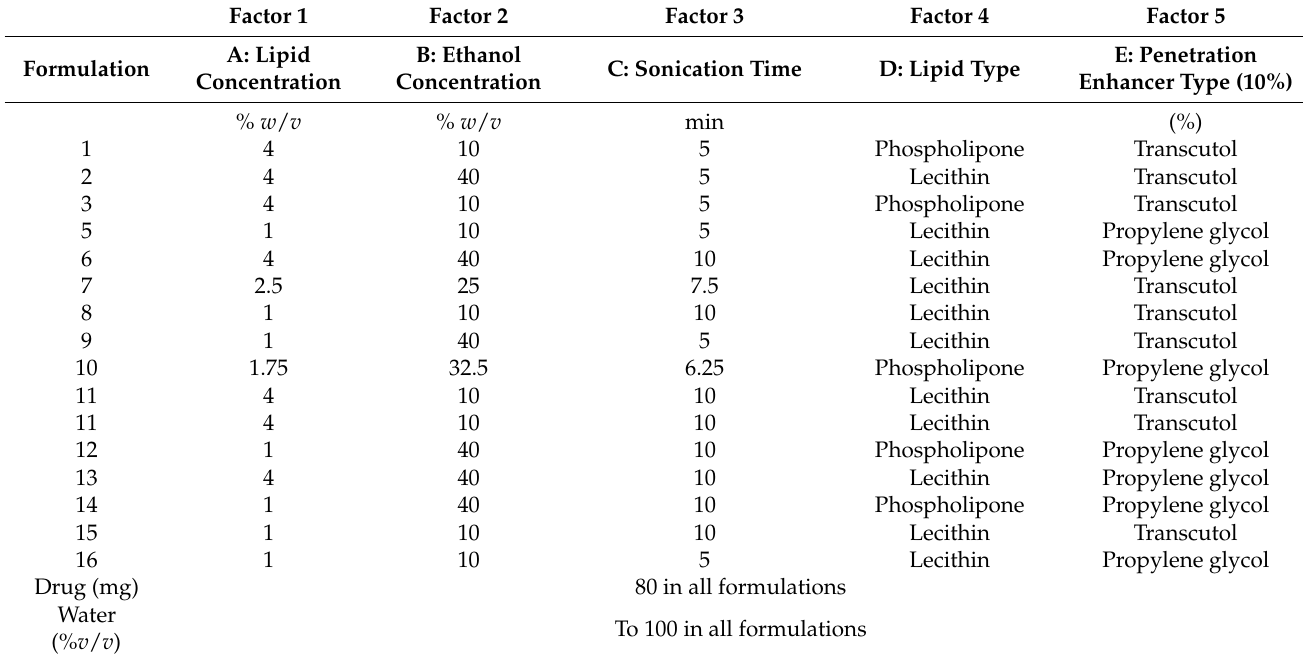
Table 1. Build information for the initial screening